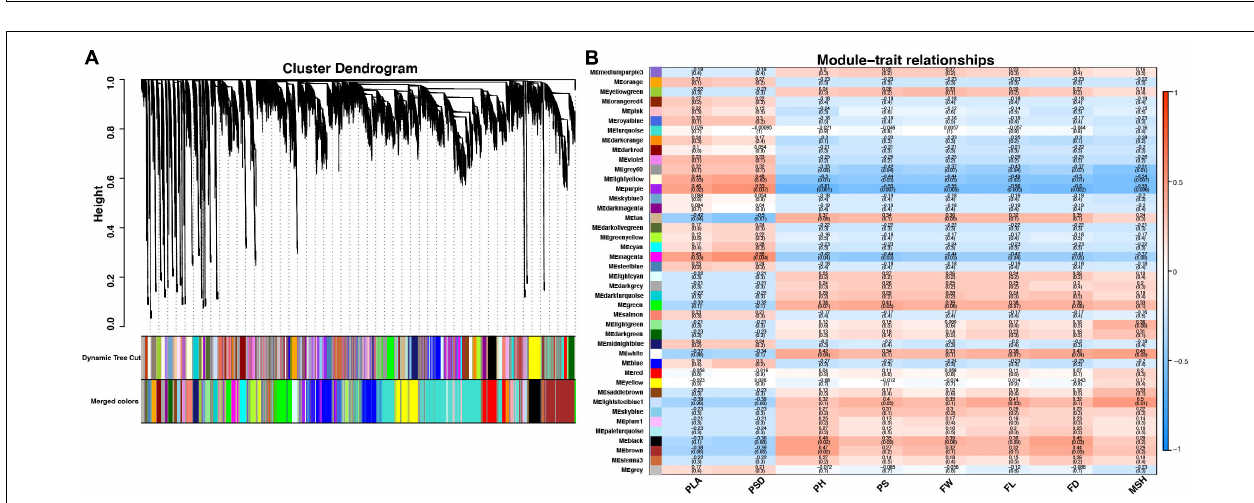
FIGURE 4 | The “plant hormone signal transduction” pathway enriched by Kyoto Encyclopaedia of Genes and Genomes (KEGG) analysis. (A) At S-stage. (B) At F-stage. Upregulated KEGG Orthology (KO) nodes are marked with red.